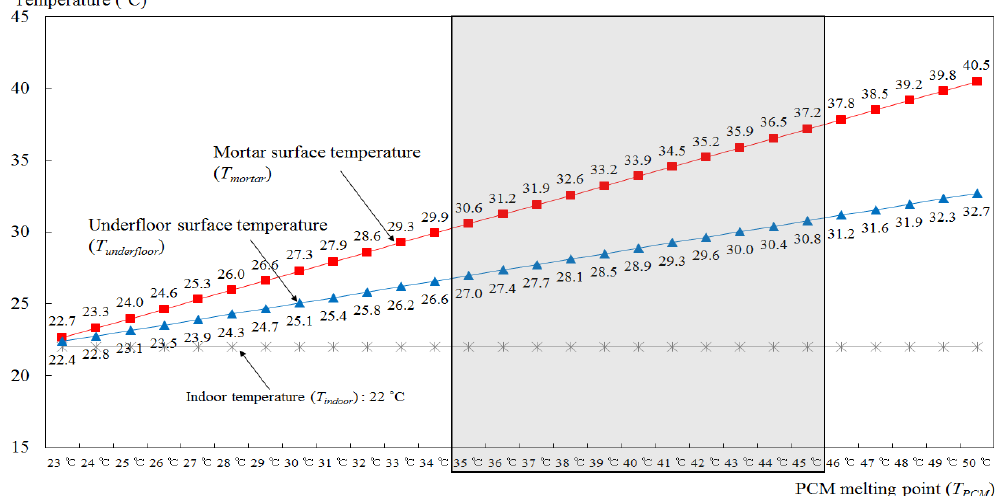
Figure 5. Mortar and floor surface temperatures according to changes in PCM melting temperature.